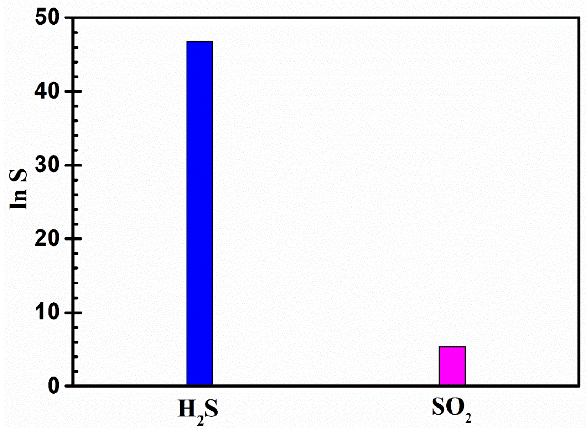
Figure 8. Sensitivity (S) of the Cu 2 Zn 10 O 12 cluster towards the H 2 S and SO 2 gases.